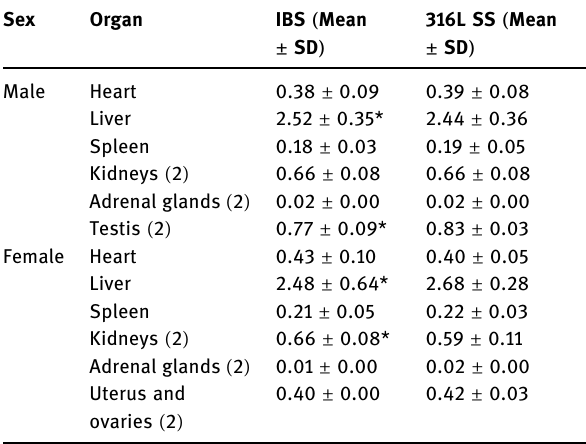
Table 4: Summary of organ/body weight ratios ( %